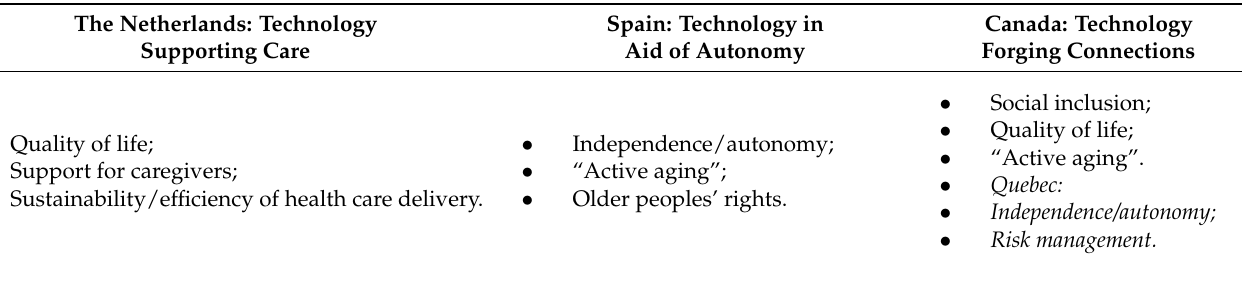
Table 2. Summary of value